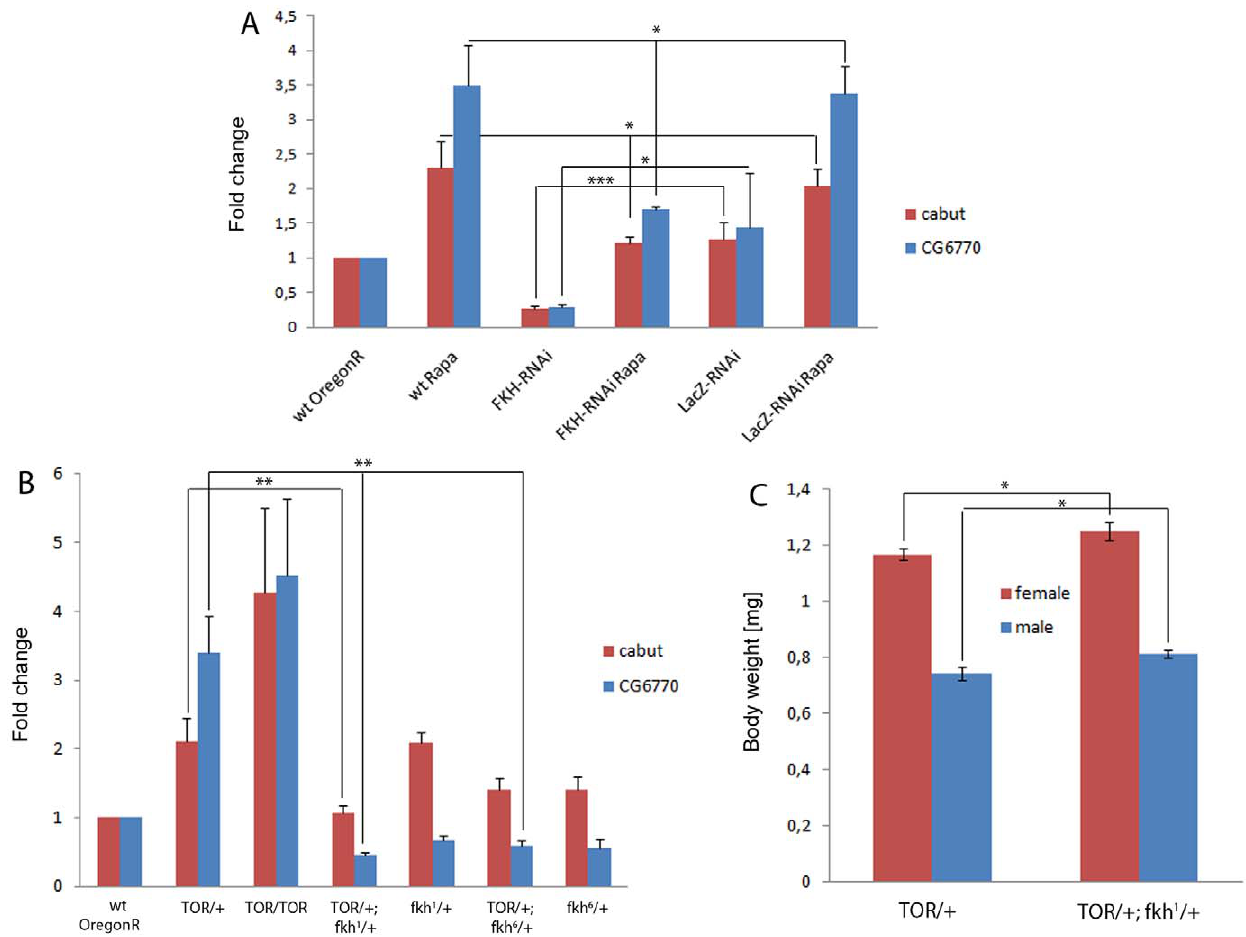
Figure 6. FKH is required for the response to rapamycin and lowered TOR levels. Realtime qPCR was performed to quantify mRNAs in larval extracts. ( A ) Transcription of CG6770 and cabut is induced upon rapamycin treatment (Rapa) and downregulated in larvae with low FKH levels ( w; arm-Gal4/ + ; UAS-FKH-RNAi/ + ). Compared to rapamycin-fed wildtype and unspecific control animals ( w; arm-Gal4/ + ; UAS-LacZ-RNAi/ + ), expression of CG6770 and cabut is significantly lower in rapamycin-fed FKH-RNAi larvae. ( B ) Consistent with the high expression of CG6770 and cabut in rapamycin-treated larvae, these genes are transcriptionally upregulated in dTOR mutants ( y w; dTOR D P / + and y w ; dTOR D P /dTOR D P ). The elevated expression is suppressed in larvae transheterozygous for dTOR and FKH ( y w; dTOR D P / + ; fkh 1 / + and y w ; dTOR D P / + ; fkh 6 / + ), indicating that FKH function is required for target gene induction by low TOR signaling. ( C ) The body weight of adult flies heterozygous for dTOR D P is increased by the presence of one copy of the fkh 1 allele. Both male and female transheterozygous flies are slightly but significantly heavier than dTOR D P / + flies. Significance was tested using an unpaired 2-tailed Student’s t-test. *=p , 0.05; **=p , 0.01; ***=p , 0.001. Error bars represent SEM.